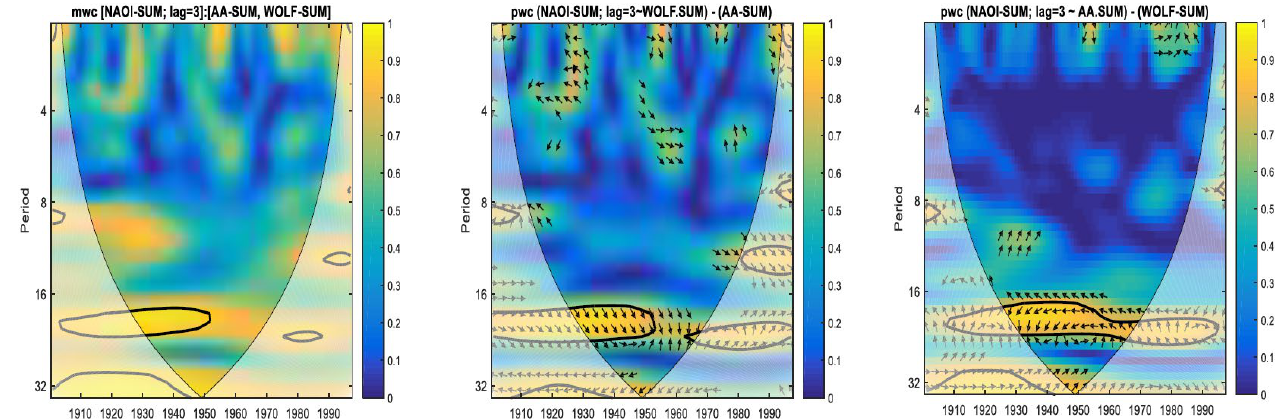
Figure 8. Mwc ( left panel ) between summer NAOI at lag = 3, and the two predictors aa (AA) and Wolf Number (WOLF); partial wavelet coherence ( pwc ) between NAOI and Wolf number, excluding the effect of aa ( middle panel ), and pwc between NAOI and aa , excluding the effect of Wolf number ( right panel ).